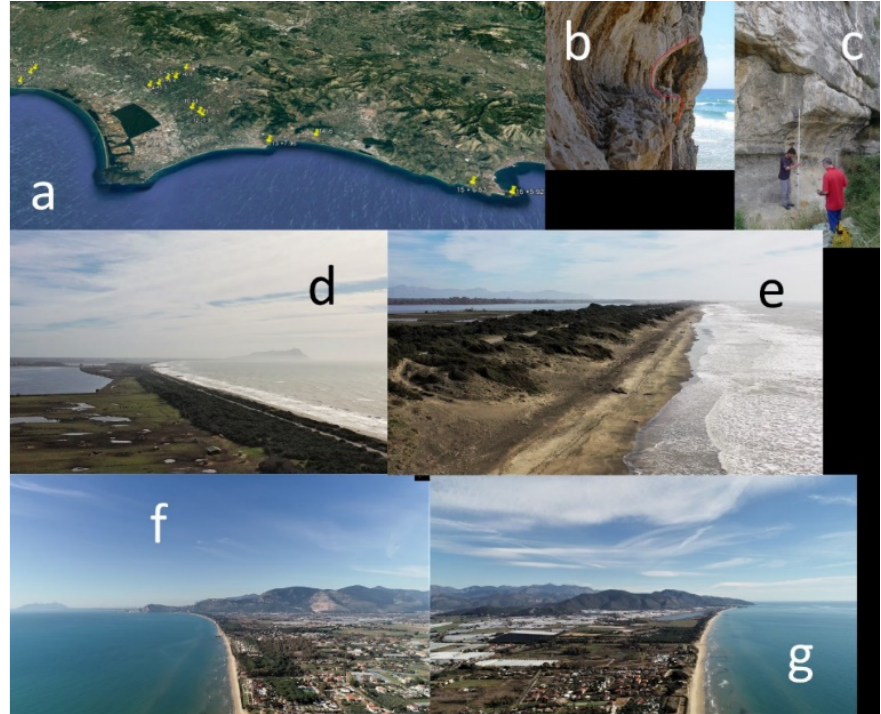
Figure 13. ( a ) Google Earth image of the Pontina and Fondi Plain with the carbonatic promontory of Terracina, Sperlonga on which are carved the fossil tidal notches; ( b , c ) aged MIS 5.5, the yellow arrow indicates the sample’s number and altitude (see Table 3) Pianura Pontina e di Fondi; ( d ) the coastal area of northern Pontina Plain (on background, the limestone Circeo promontory); ( e ) the coastal area of northern Pontina Plain (on background, the limestone Terracina promontory; ( f ) the coastal area of the Fondi Plain (on background, the limestone Terracina Promontory; ( g ) same point but a southern view, with Sperlonga promontory.